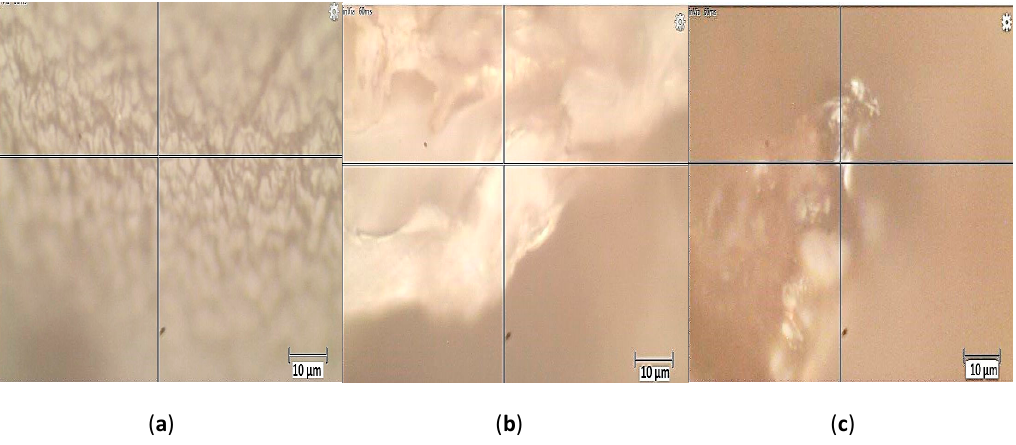
Figure 2. Photos of the analyzed regions by Raman spectroscopy: ( a ) CA beads, ( b ) CA–SCGs beads ( c ) SCGs.